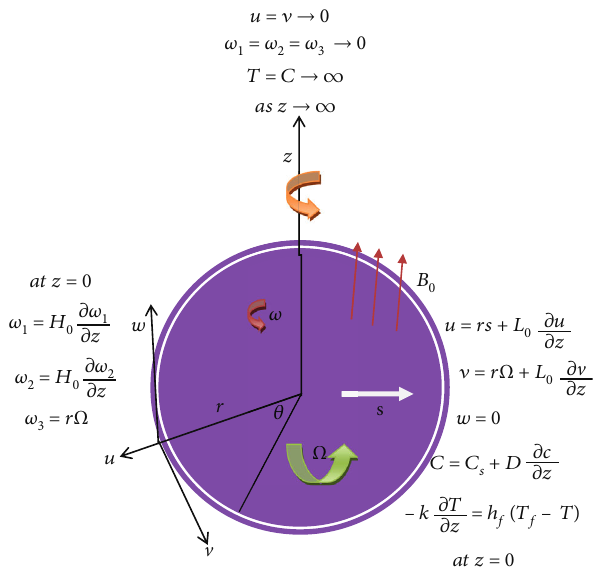
Figure 1: Physical fl ow con fi